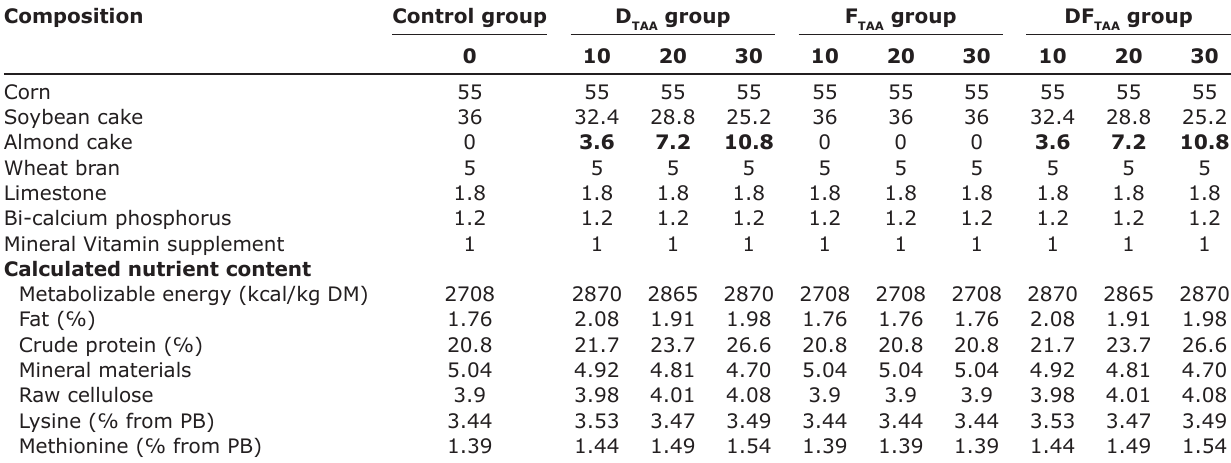
Table-3a: Formulas (kg/100 kg feed) of starter-growth (1-20 days) feeds to quail based on the rate of substitution of soybean meal by apricot kernel meal. Composition